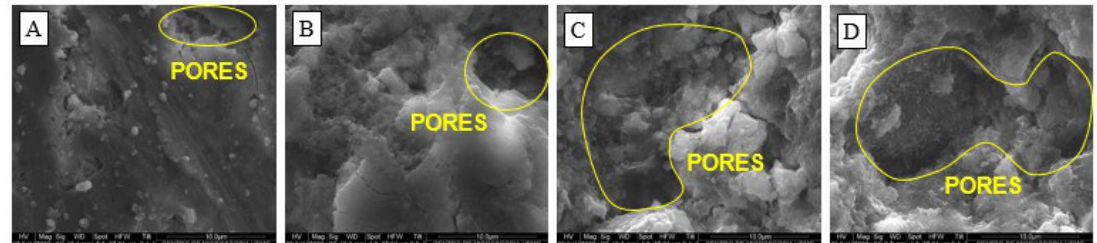
Figure 7. Images generated by SEM (SE) with a magnification of 5,000 times for the four consolidation conditions: w/c 0.55